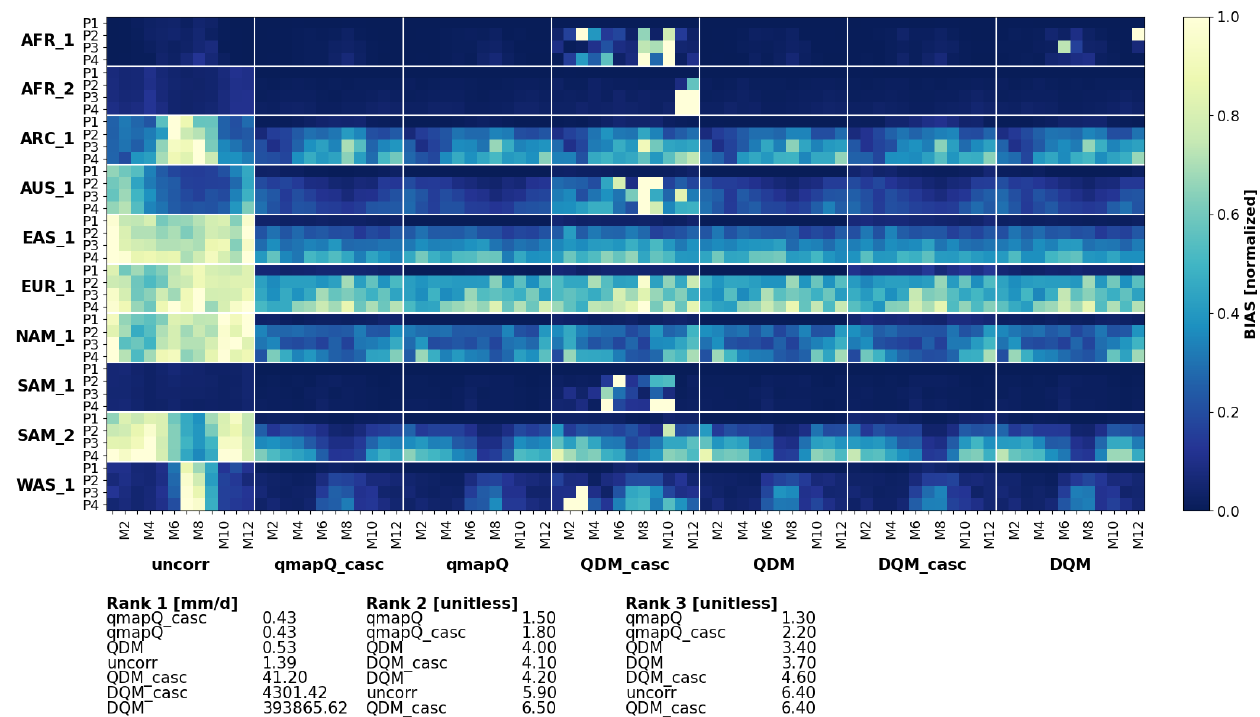
Figure 4. Bias of mean precipitation in the original data (uncorr) and after applying the different bias adjustment methods with (subscript “casc”) and without temporal cascades. P1–4 mark the evaluation periods 1971–2000 (also the calibration period), 2011–2040, 2041–2070, and 2071–2100. The results are presented for each of the domains (vertical) and for each month of the year (M1–12). The results are normalized for each sub-panel, i.e. each domain, such that the bias of the uncorrected data and all methods are in the range 0–1.